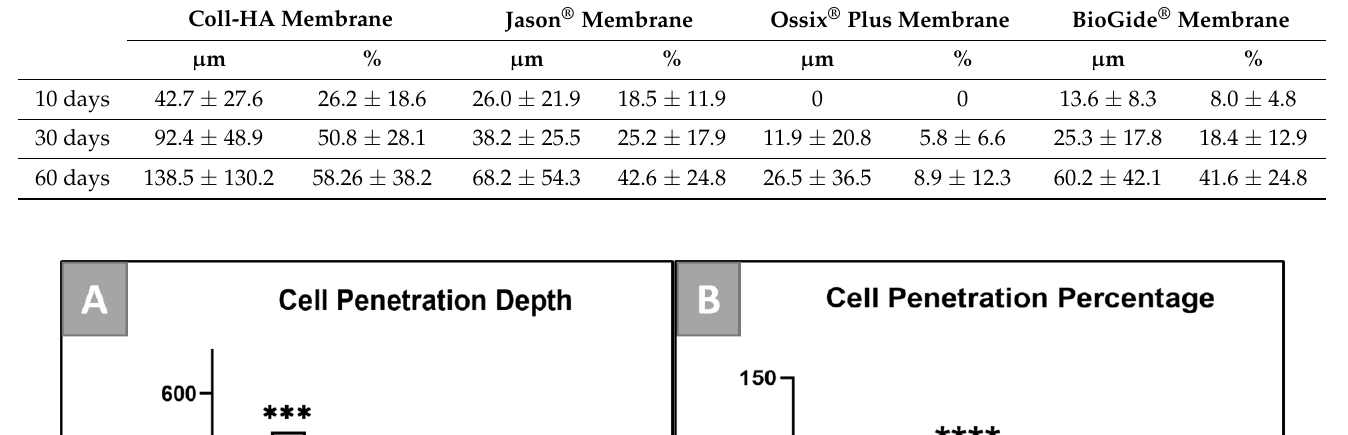
Table 1. Results of the cellular penetration in the four different study groups (mean values ± standard deviation).